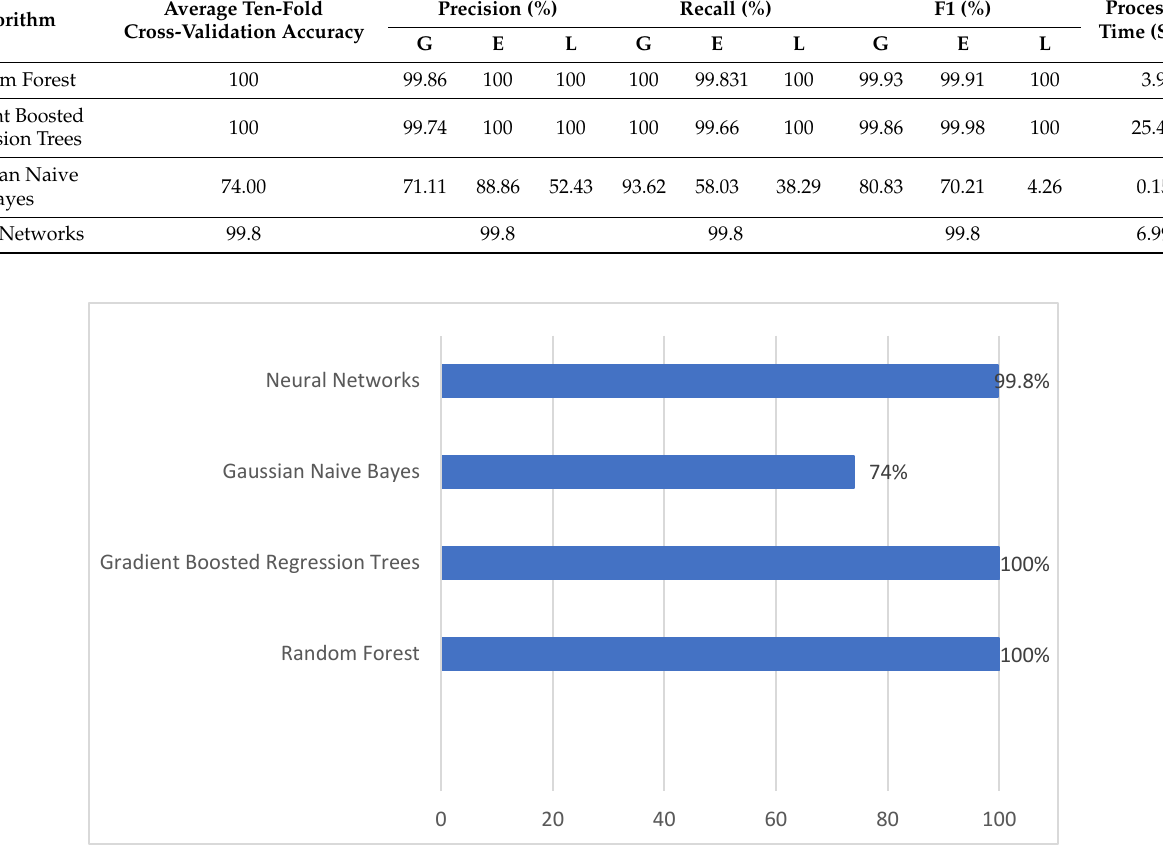
Table 5. Performance of the classifiers using the dataset obtained in step 2.